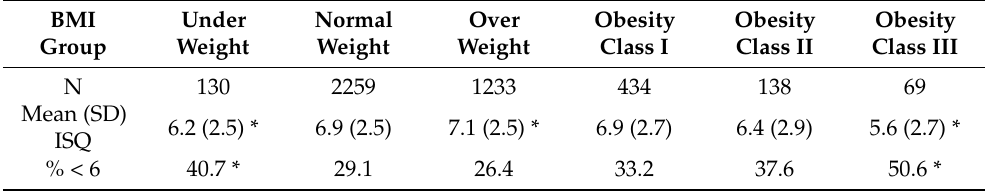
Mean and standard deviation (SD) or percentages are shown. Differences from the normal weight group are considered statistically significant if p < 0.01 (after Bonferroni’s correction for multiple com- parisons), indicated by *. % < 6 = subjects with an ISQ score <6, suggesting reduced immune fitness.